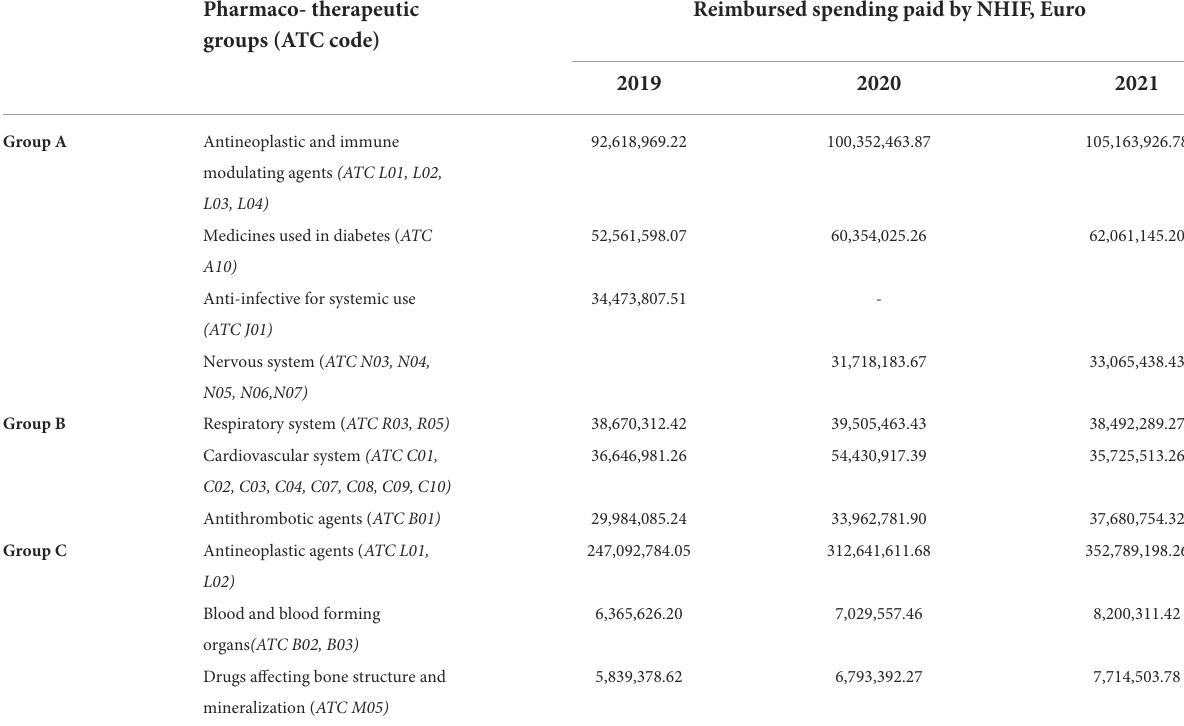
TABLE 4 Pharmaco-therapeutic groups with the highest reimbursed spending during